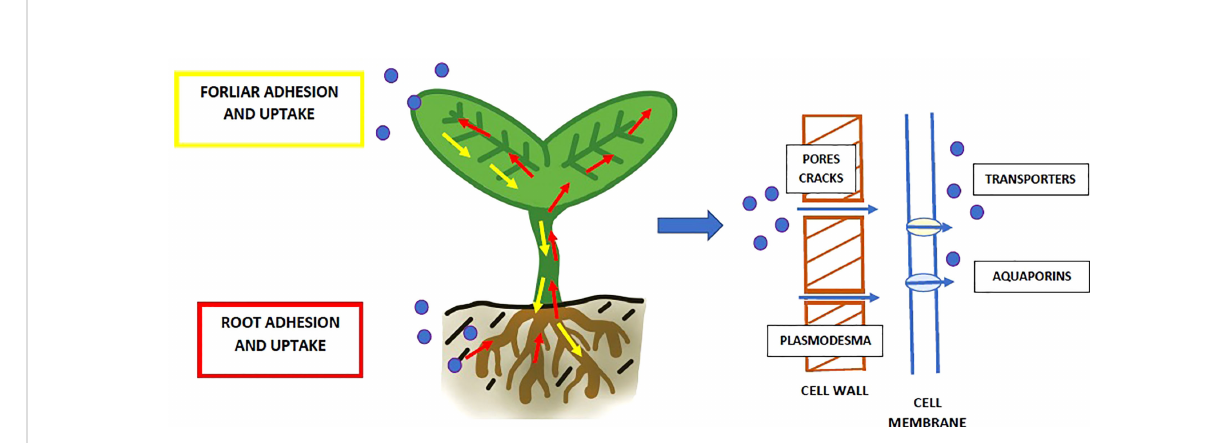
FIGURE 4 Uptake NP (blue dots) from the surrounded environment and transport through the plant organisms. Plastic particles may enter by roots (marked with red arrows) and leaves (marked with yellow arrows). The NP may enter the cell through pores and cracks in the cell wall and further through plasmodesma or transporters/aquaporins in the cell